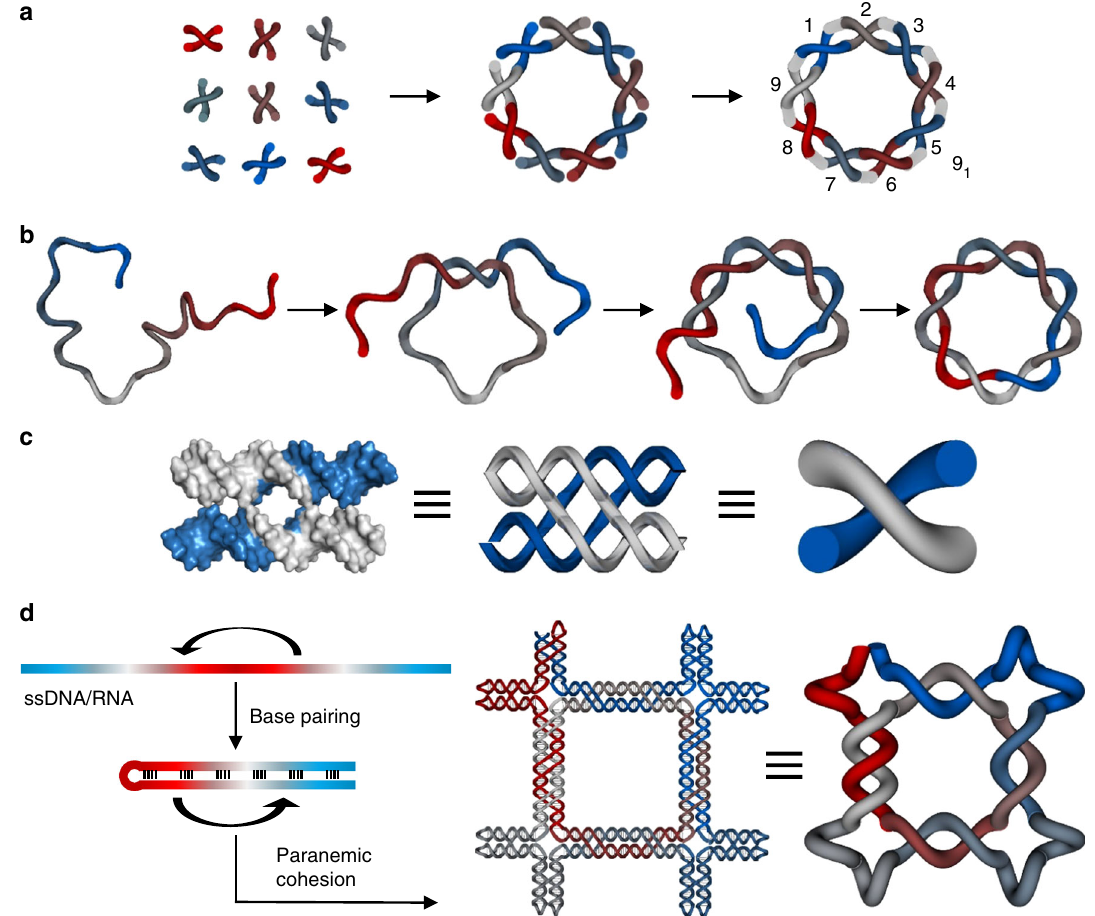
Fig. 1 Design of single-stranded DNA (ssDNA) or RNA knots. A knot with a crossing number of nine can be constructed via two strategies: a Assemble with preformed individual X-nodes that are linked together with speci fi c sticky ends associations and ligation. b Thread and knot a single chain into the target topology. The color scale shows different regions of a single chain. c Paranemic crossover motifs were introduced as the building blocks for the knotted nucleic acid nanostructures. d A schematic diagram that shows the design and folding pathway of a ssDNA to form knot 9 1 as an example (The color scale shows different regions of ssDNA/RNA). A single-chain DNA was assigned with partially paired regions to fi rst form a large loop-stem hairpin structure. Then, the unpaired loop regions were designed to interact with each other through paranemic cohesions to form the target knot. The formation of the knot involved the threading of the two ends of the loop-stem structure by following a pathway similar to that shown in